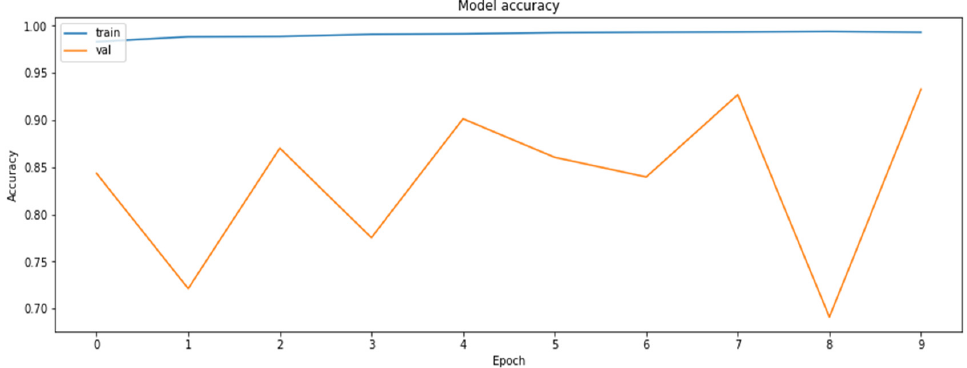
Figure 6. The accuracy of the model on the training and the validation datasets obtained during the training with the application of the QAT